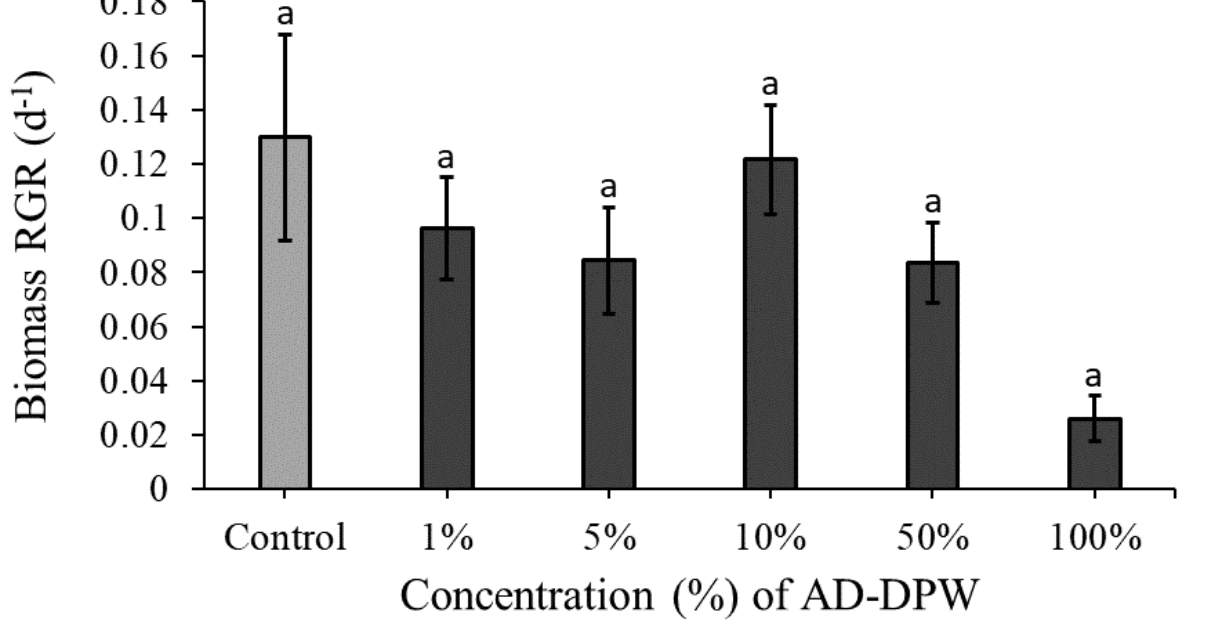
Figure 1. Mean ( ± SE) RGR (d − 1 ) of Lemna minor cultivated on AD-DPW at 1%, 5%, 10%, 50%, and Figure 1. Mean (±SE) RGR (d −1 ) of Lemna minor cultivated on AD-DPW at 1%, 5%, 10%, 50%, and 100% concentrations in one-week experiments, as well as a control treatment. “a”: Denoting no 100% concentrations in one-week experiments, as well as a control treatment. No significant differ- significant difference was detected through post hoc ence was detected through post hoc analysis.